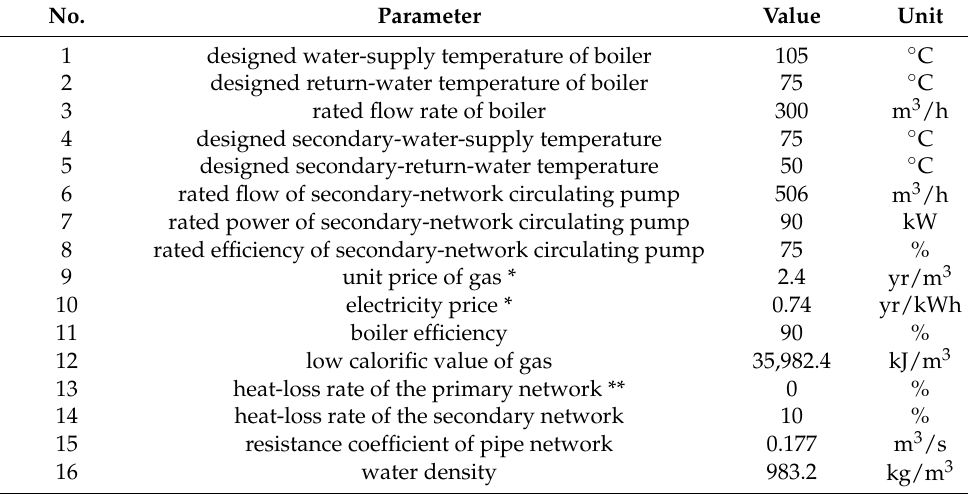
Table 1. Parameters of the studied heating